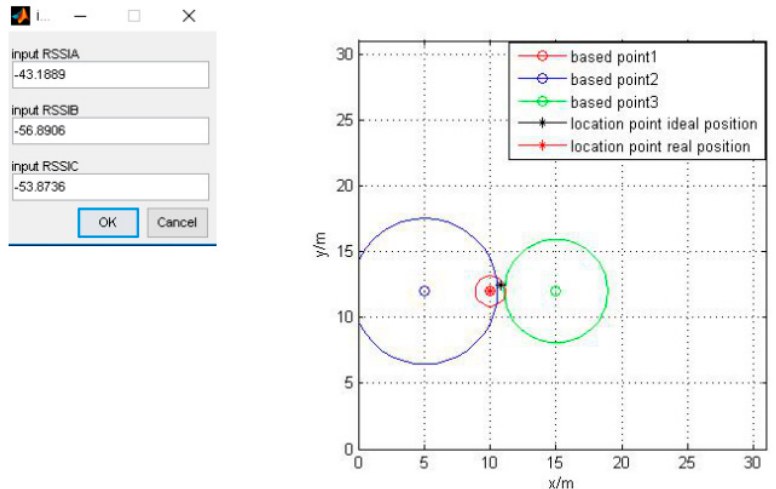
Figure 6. Simulation result when the RSSI values are − 43.1889, − 56.8906, and − 53.8736 (dBm) for the three points (a, b, and c).